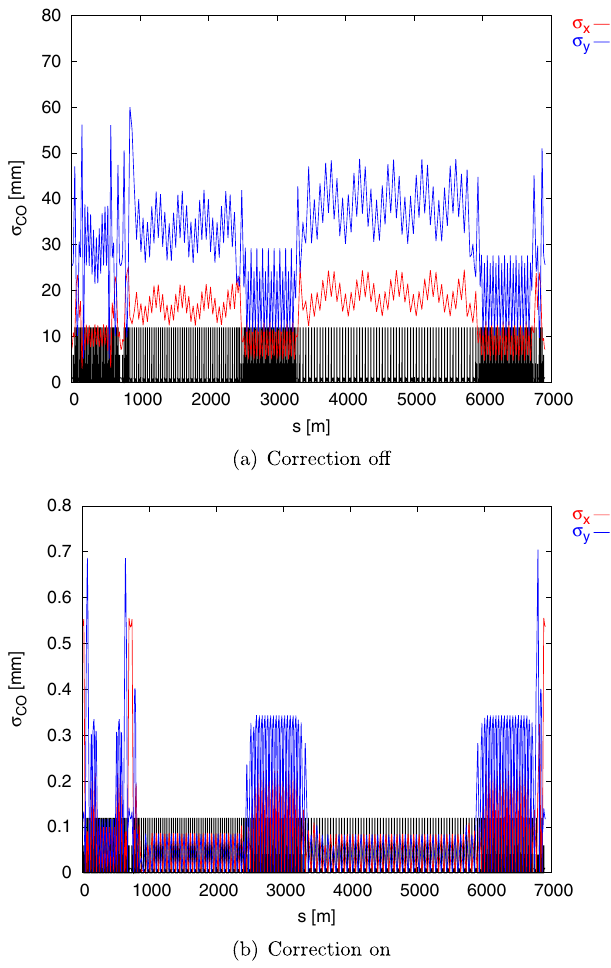
FIG. 39. Dynamic aperture around the chromatic orbit for 10,000 turns at the middle of the injection insertion.